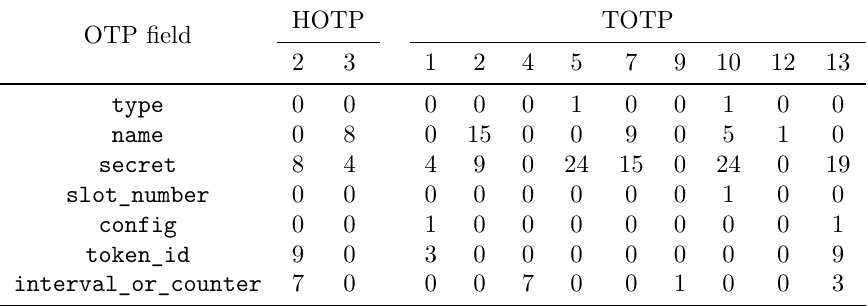
Table 3: Number of bytes for each OTP entry that cannot be extracted from the flash memory of the Nitrokey Pro 2. The fields represent the struct members of each entry as used by the firmware. Entries that can be fully extracted are omitted for clearness.